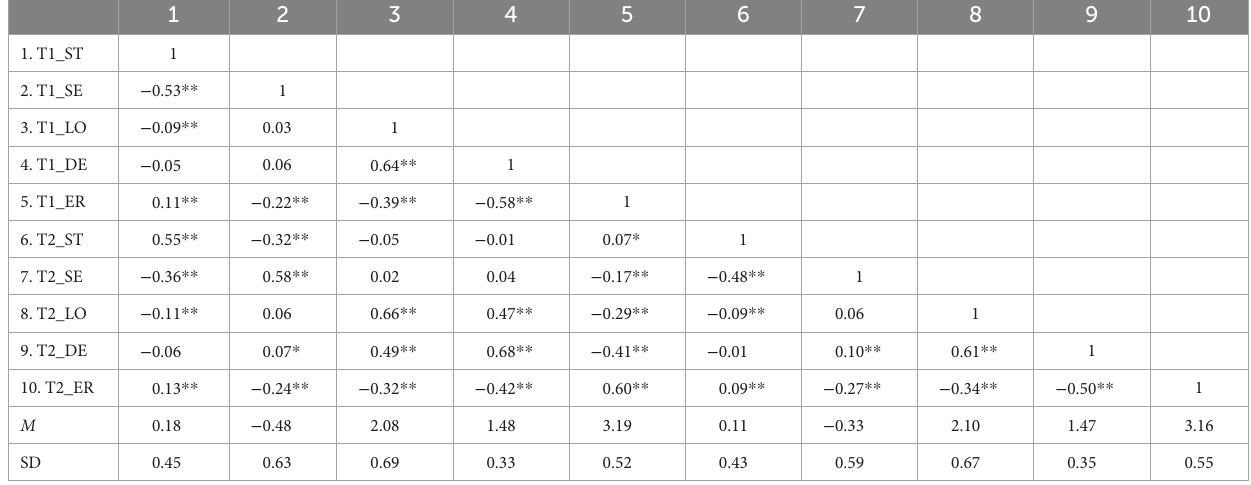
TABLE 1 Means, standard deviations, and correlations among study variables ( N = 863).